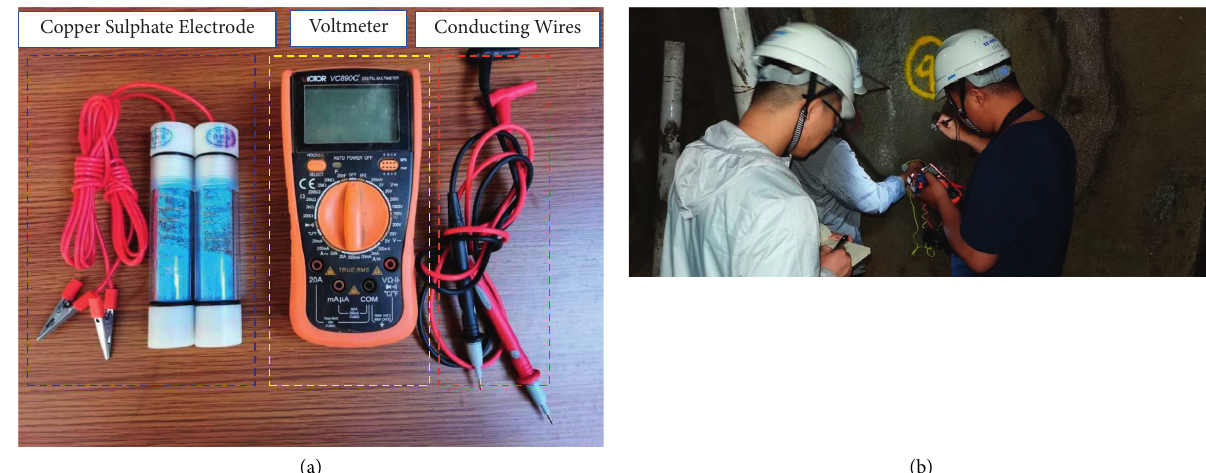
Figure 8: The stray current measurement. (a) The stray current measure device. (b) Field test.